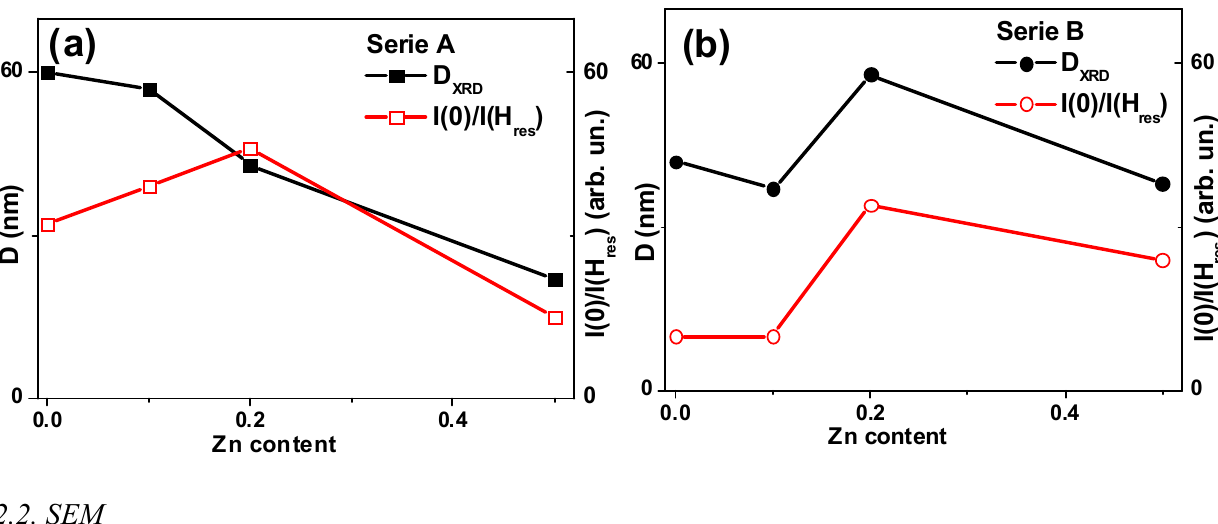
Figure 3. SEM images of sample A-III (Zn